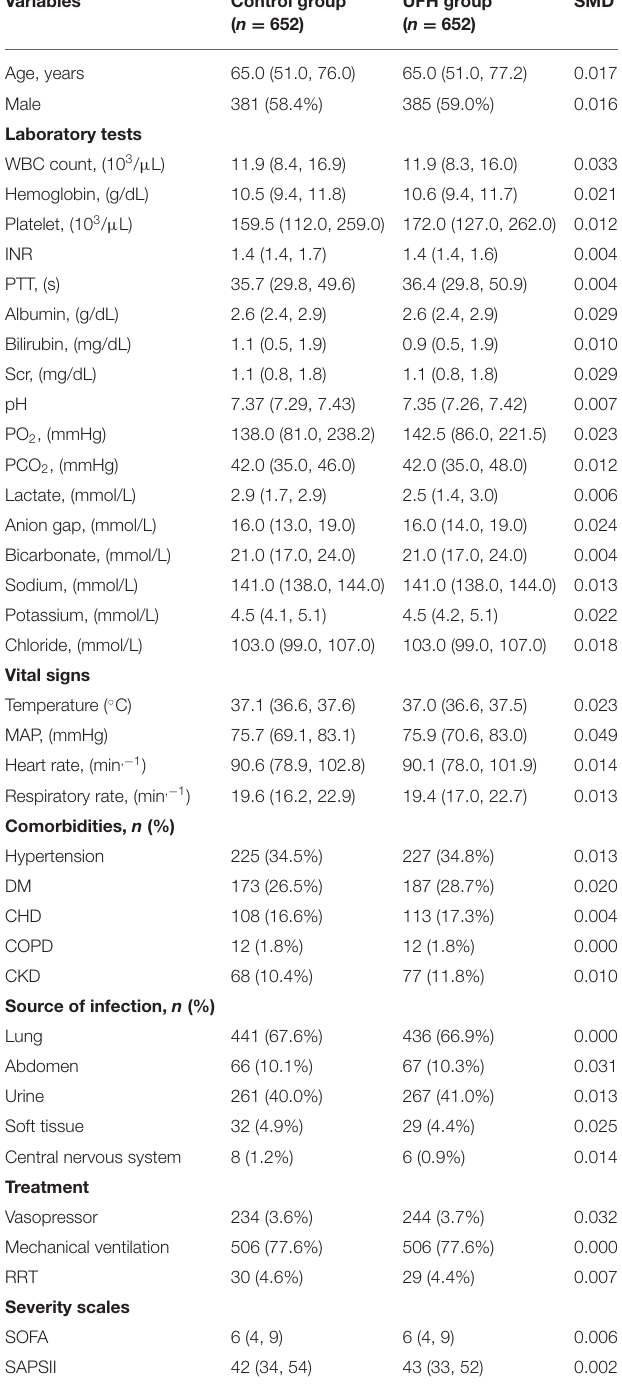
lower 28-day mortality compared with the control group (17.0% TABLE 3 | Comparisons of the covariates after propensity score matching. vs. 36.4%, p < 0.001). The 28-day Kaplan-Meier survival Variables Control group curves also showed that patients in the UFH group had higher ( n = 652) survival probability compared to the control group ( p < 0.001) ( Figure 2A ). For hospital mortality, it was still significantly lower in the UFH group compared with the control group (19.7%